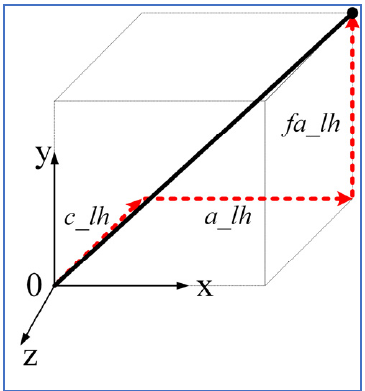
Figure 7. Cuff end location estimation along axes.